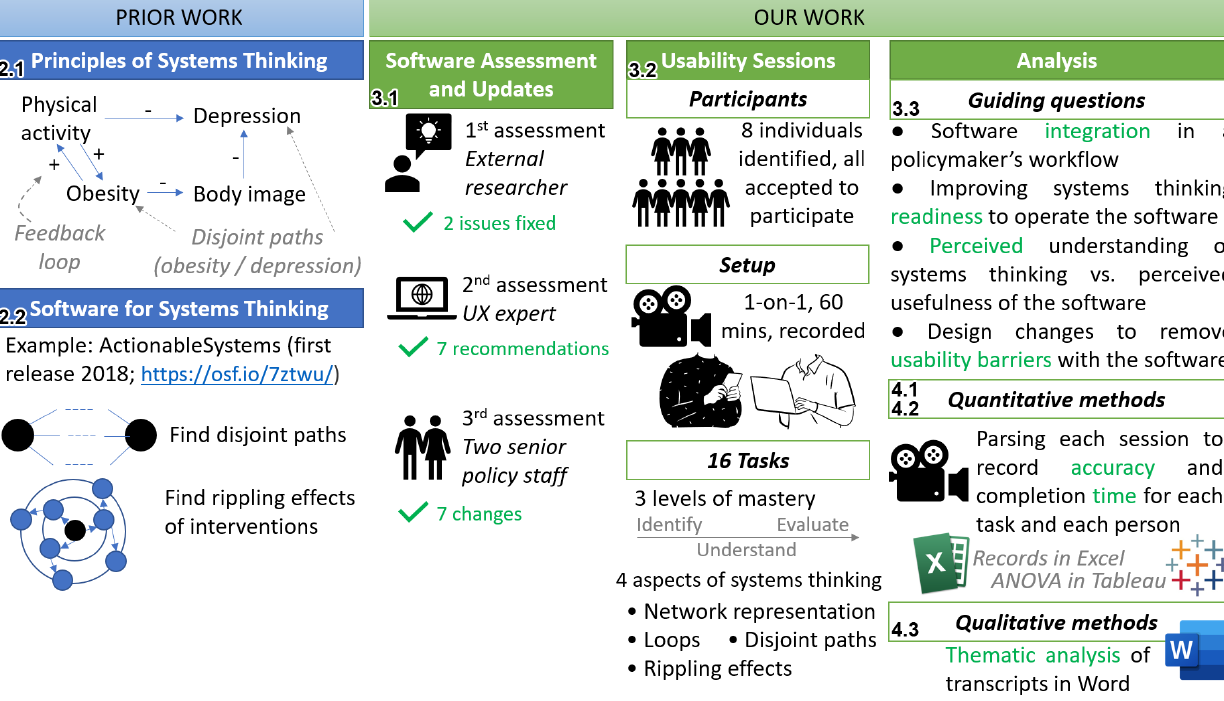
Figure 1. Key components of this study along with corresponding subsections.